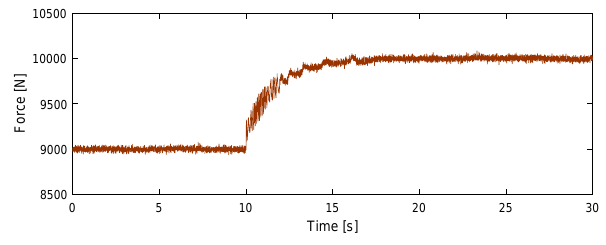
Figure 18: Elimination of limit cycle oscillations, tran- sient response.